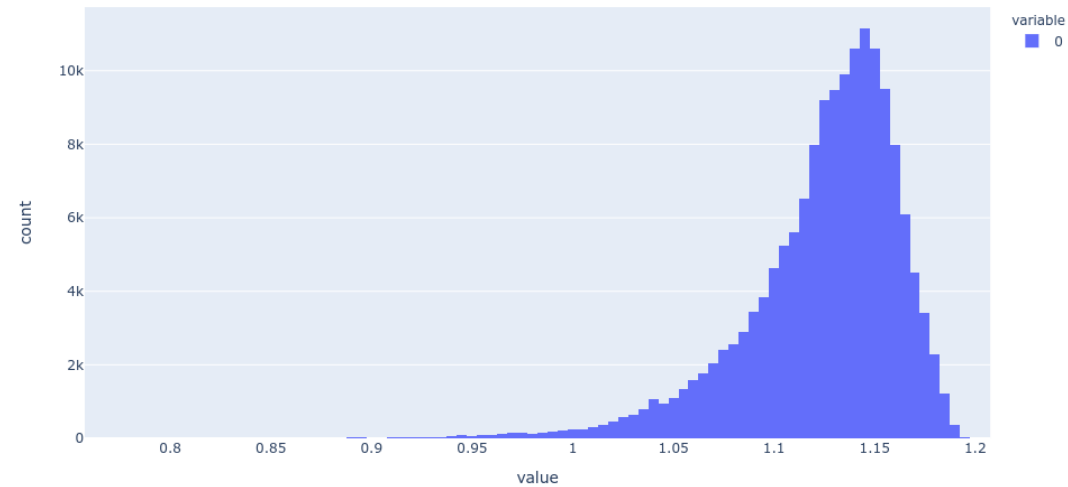
Figure 7. Histogram of the population of dimension 25 for the 256-D dataset. It is evident that most molecules adopt only a small range of non-zero values in this dimension.